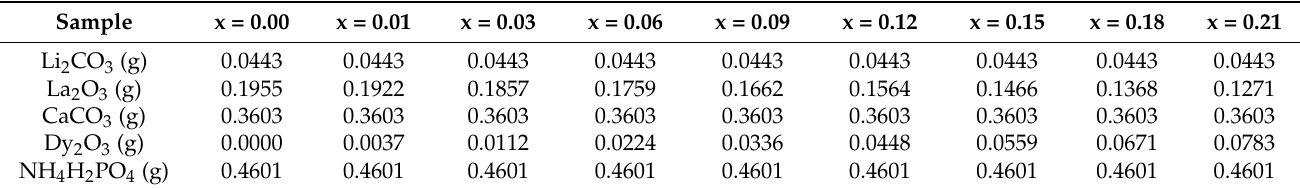
Table 1. Quality of raw materials for Ca 1.8 Li 0.6 La 0.6 − x (PO 4 ) 2 :xDy 3+ .